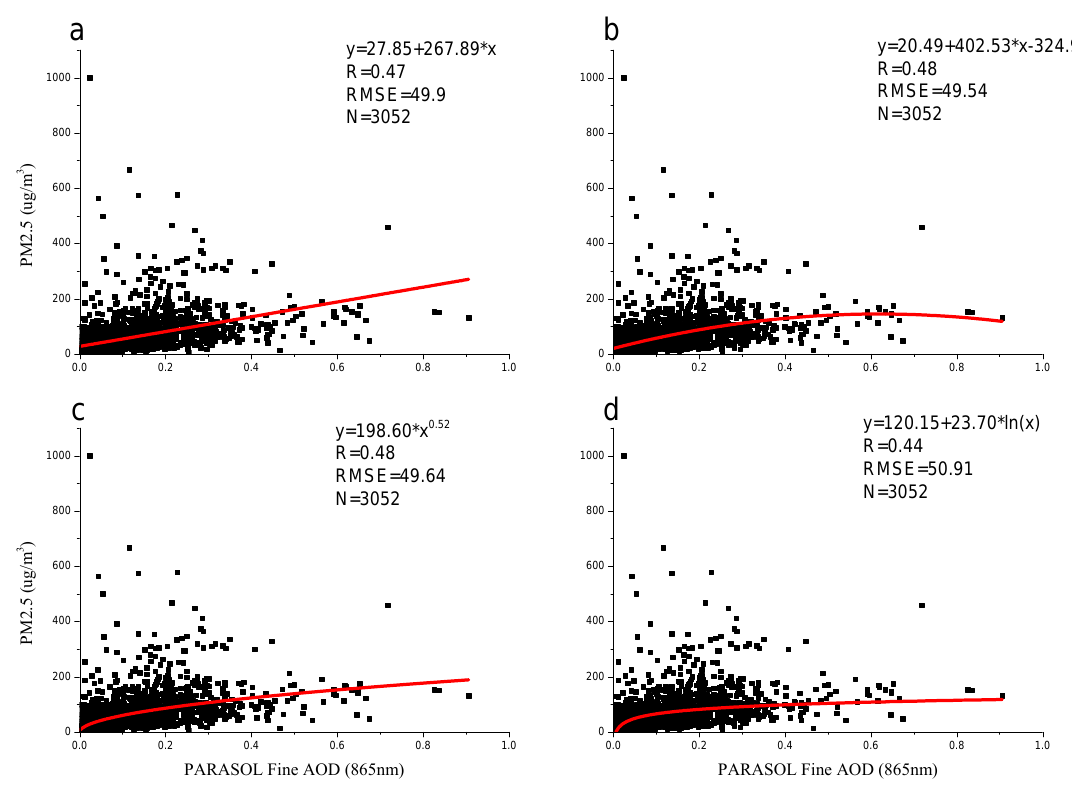
Figure 2. The four regression models based on PM 2.5 concentrations and PARASOL AOD data ( p < 0.05) ( a ) the linear regression model; ( b ) the quadratic regression model; ( c ) the power regression model; and ( d ) the logarithmic regression model.